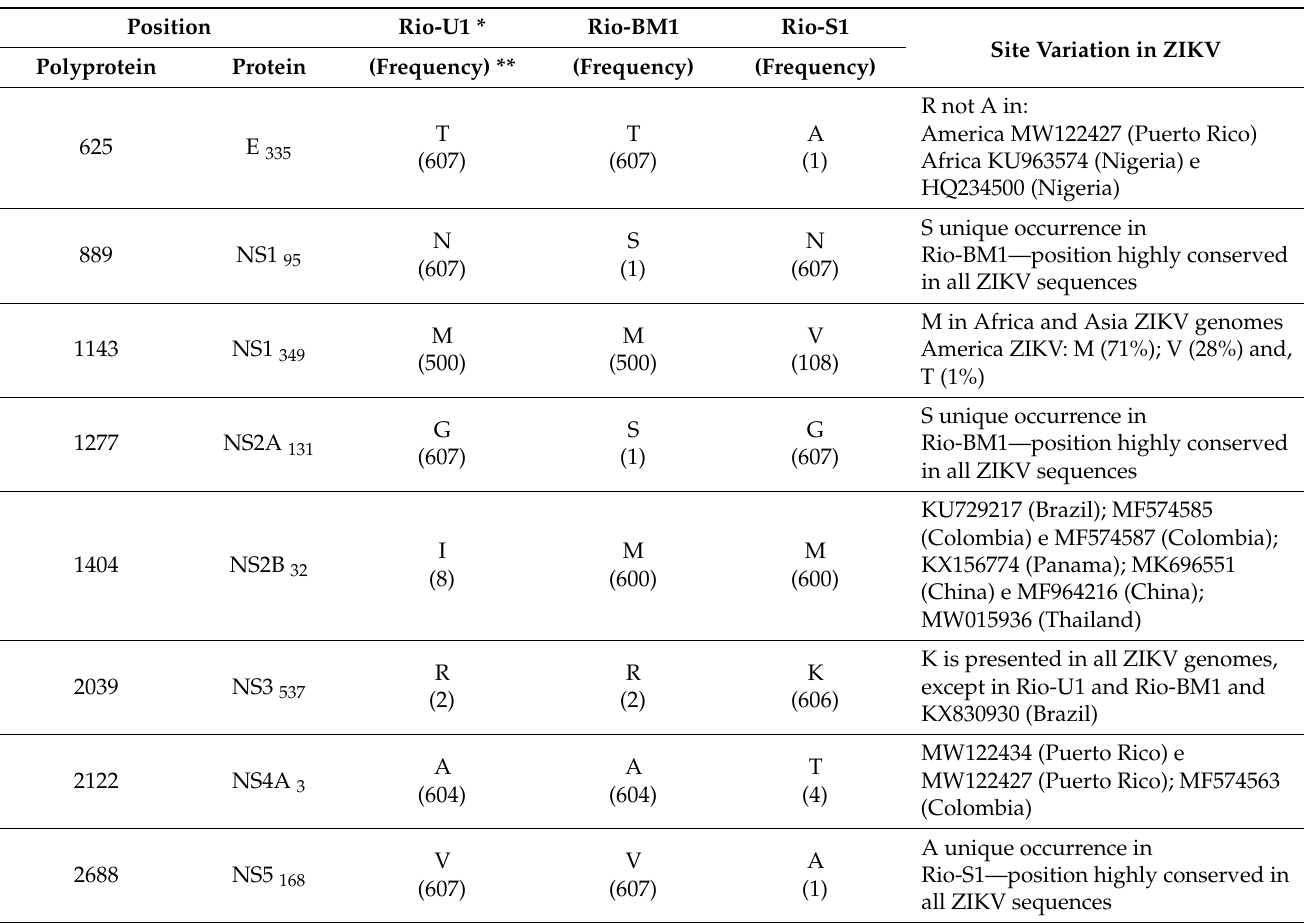
* Amino acid variations colored in blue; ** frequency in 608 ZIKV